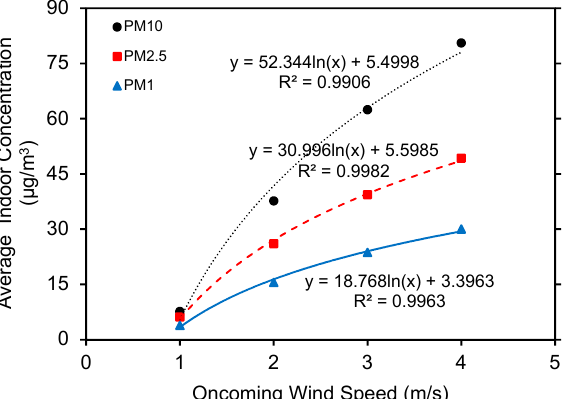
12 of 21 Figure 9. Particle concentrations along the horizontal plane at y = 53 m and z = 1.5 m in the baseline scenario. 3.2. Oncoming Wind Speed and Window Opening Size Oncoming wind velocities are set to 1.0, 2.0, 3.0, and 4.0 m/s to explore the effects of oncoming wind velocity on indoor particle concentration distributions (Figure 10). For clarity, only scenarios where CVC = 0.8 m 3 /m 2 are presented. Particle concentrations tend to increase exponentially with the